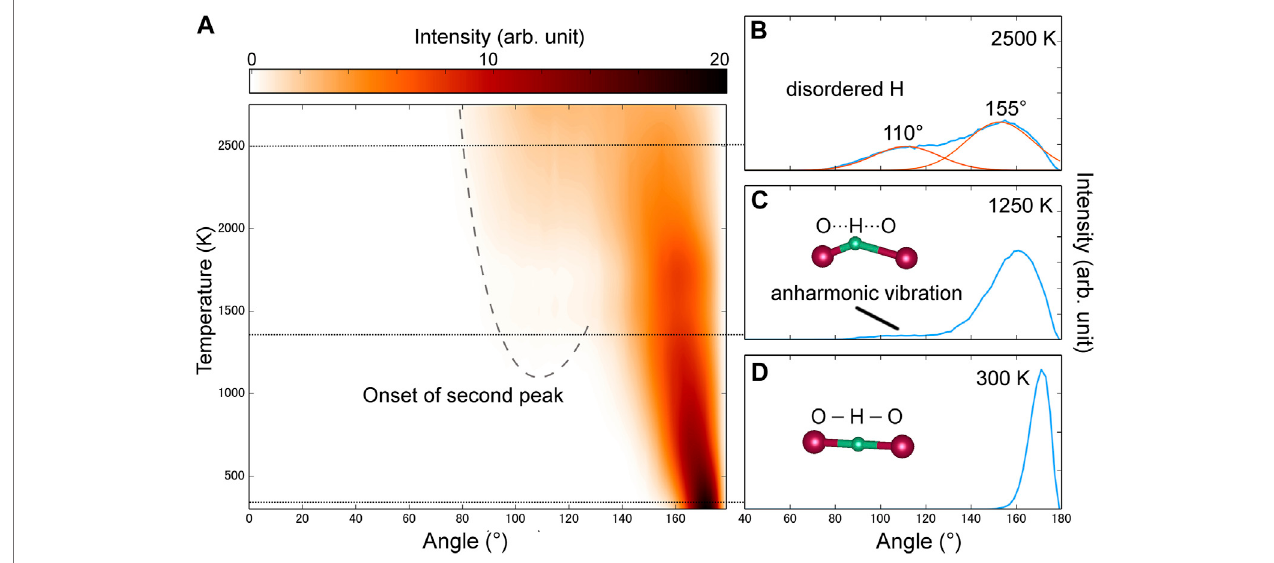
FIGURE 3 | Angular distribution of O-H-O bonding at 100 GPa and various temperatures. (A) Interpolated contour. High-intensity distributions are generally in darker colors. We observed an increased number of angles fell around 105 ° in the anharmonic solid and the superionic state. (B – D) Selected angular distribution spectroscopy at 2,500, 1250, and 300 K, respectively. In b , the angular distribution is fi tted to Gaussian functions with R = 0.99. The fi tted Gaussian is located at 110 ° and 155 ° . Inset fi gures are schematic representation of hydrogen bonding at different angles.